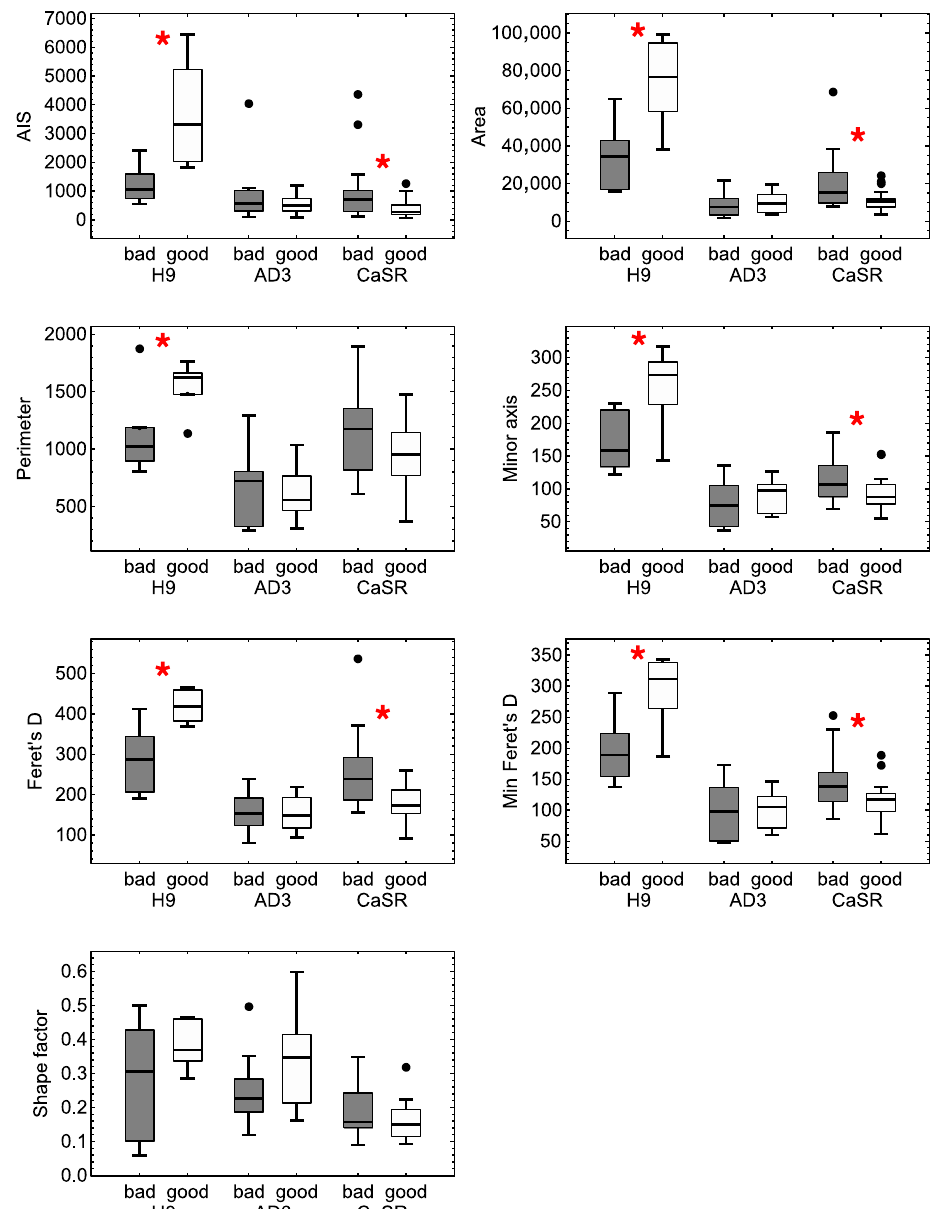
Figure 5. Boxplots showing the variance in colony morphological parameters within groups of different phenotypes for each cell line. Data comprise colonies in all passages and for growth times in the range of 24–48 h. Dots mark outliers. Asterisks indicate groups with a statistically significant ( p < 0.05) difference in the mean values of the parameters.